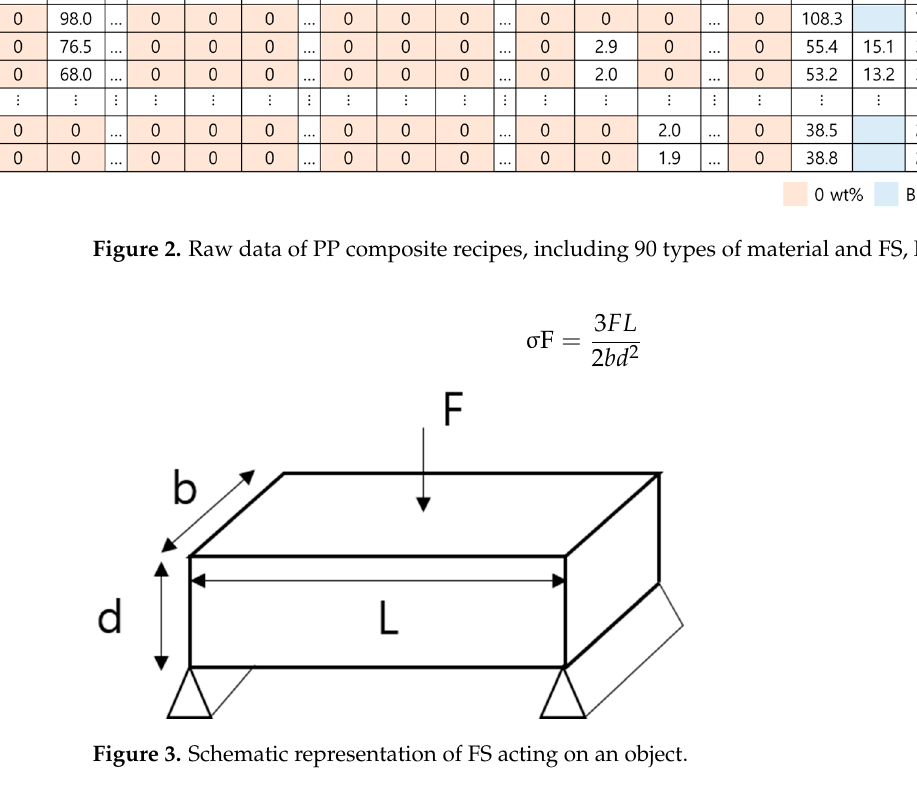
Figure 3. Schematic representation of FS acting on an object.